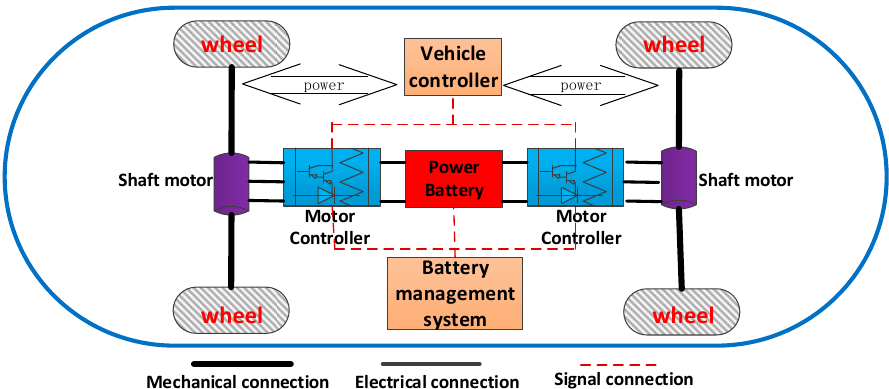
Figure 2. All-wheel simultaneous drive mode ( k = 0.5).